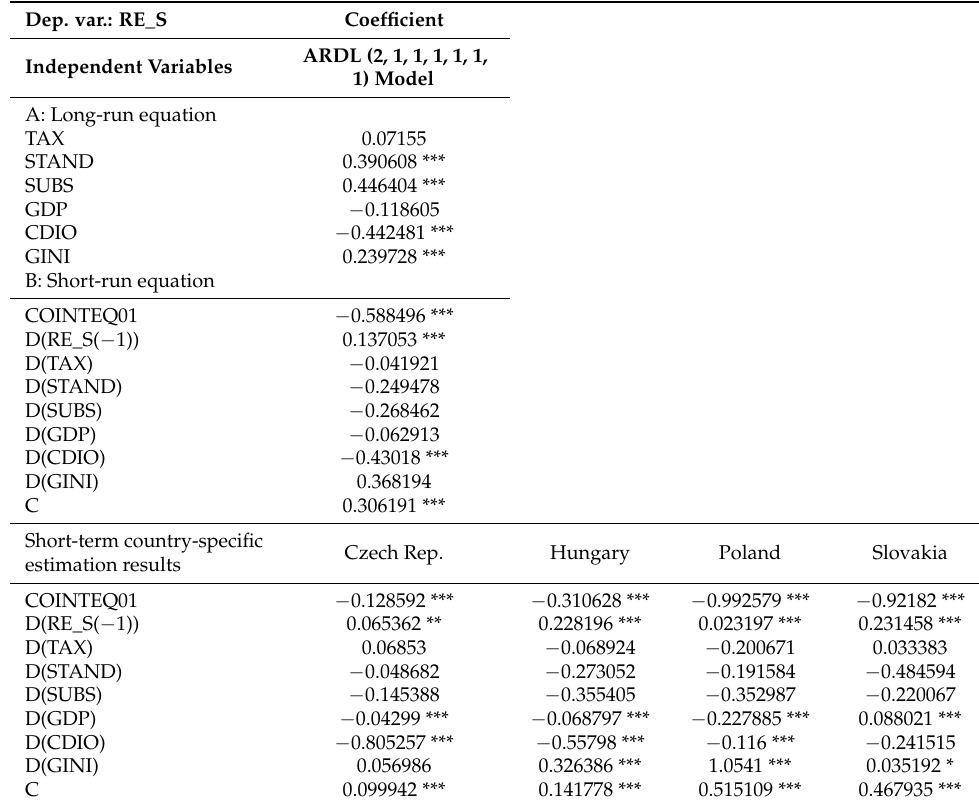
Table 19. Long-run and short-run coefficients for model